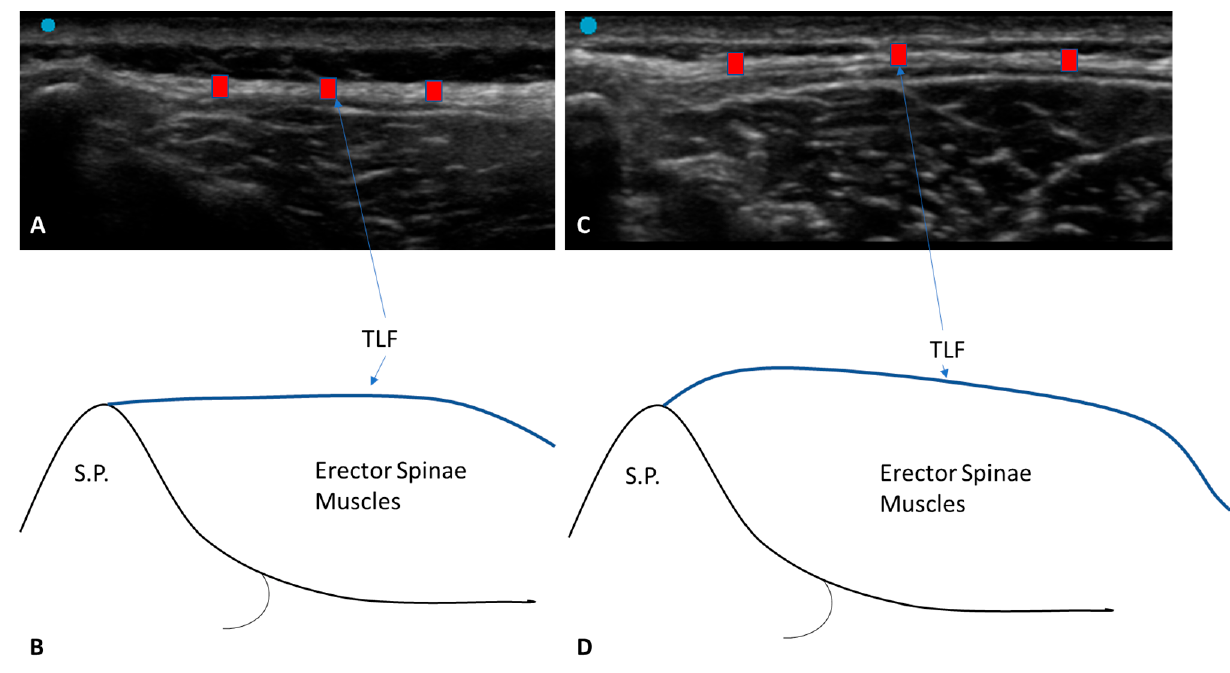
Figure 5. Ultrasound images of the TLF thickness: ( A ) Group 1: transverse axis; ( B ) Group 1: non- tensional force on the TLF; ( C ) Group 2: TLF profile in the transverse axis; ( D ) Group 2: TLF profile in the transverse axis. Red square: TLF.